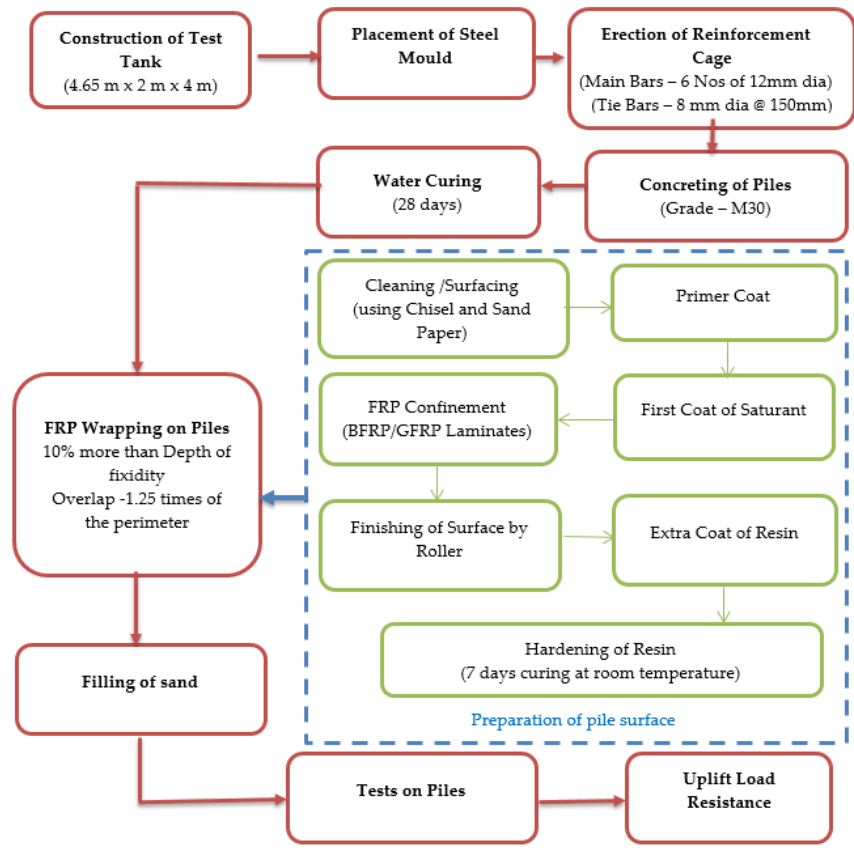
Figure 4. Casting and testing of the FRP-wrapped piles.